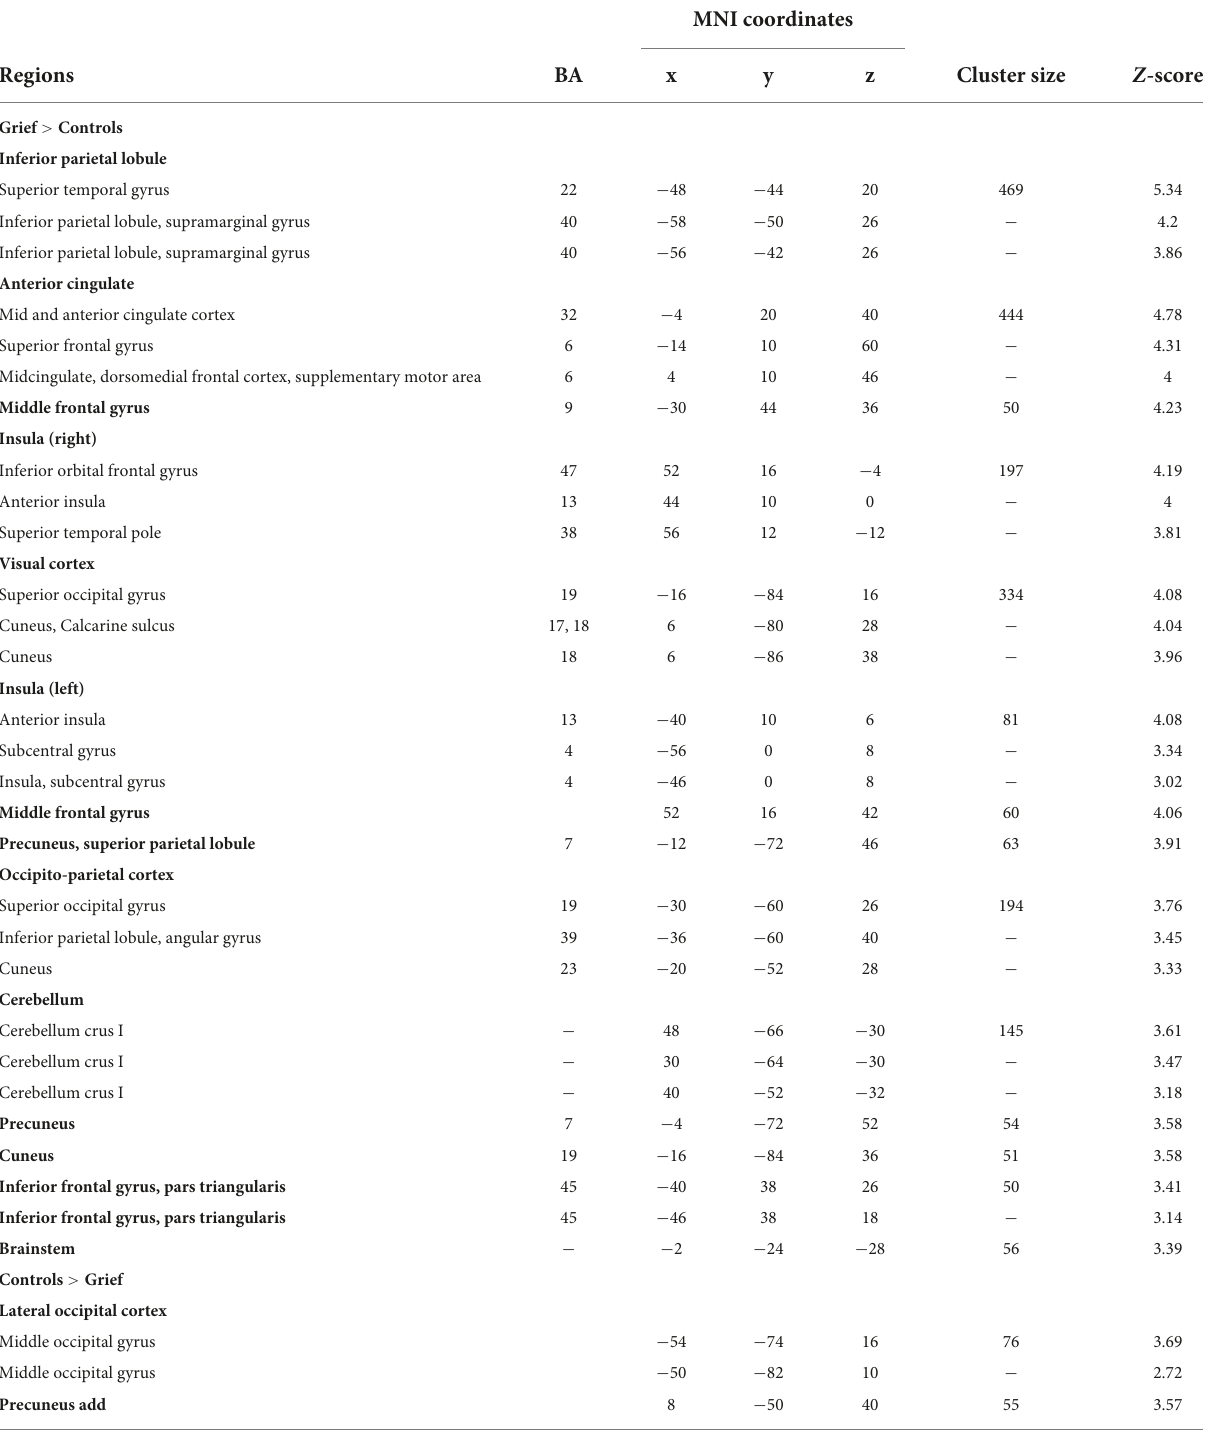
MNI coordinates